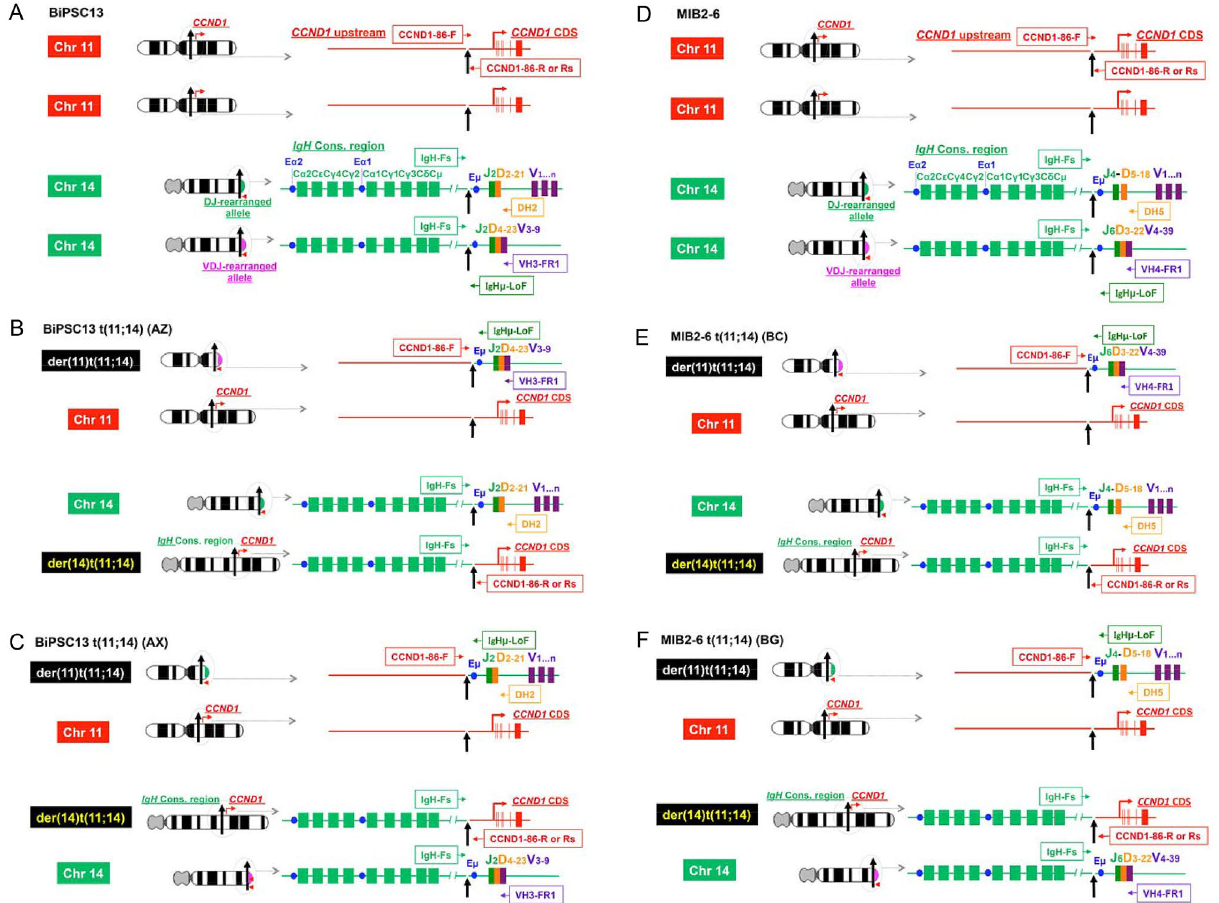
Figure 1. Features of the reciprocal chromosomal translocation (cTr) between CCND1 on chr 11 and IgH on chr 14. (A, D) Two pairs of IgH on chr 14 and CCND1 on chr 11 of BiPSC13 and MIB2-6 are shown. The cleavage site of CRISPR/Cas9 is indicated by ( ↑ ). The bent arrows and arrowheads indicate the direction of transcription of CCND1 and IgH , respectively. CCND1-86F, CCND1-86R, IgH-Fs, DH2, DH5, VH3-FR1, VH4-FR1, IgHu-LoF represent PCR primers for the confirmation of cTr t(11;14). (B) Reciprocal cTr between the functional allele (V 3-9 D 4-23 J 2 ) of IgH and CCND1 in BiPSC13 (AZ). (E) Reciprocal cTr between the functional allele (V 4-39 D 3-22 J 6 ) of IgH and CCND1 in MIB2-6 (BC). (C) Reciprocal cTr between the non- functional allele (D 2-21 J 2 ) of IgH and CCND1 in BiPSC13 (AX). (F) Reciprocal cTr between the functional allele (D 5-18 J 4 ) of IgH and CCND1 in MIB2-6 (BG). (G)(H) Confirmation of reciprocal cTr between IgH and CCND1 with PCR. PCR in BiPSC13 and two types of BiPSC13 with t(11;14) (AZ and AX) (G) and PCR in MIB2-6 and two types of MIB2-6 with t(11;14) (BC and BG) (H). Refer to (A) and (D) above for the location of each primer. The numbers indicate the length of the PCR product estimated from the database. (I) Confirmation of der(14) t(11;14) and der(11)t(t(11;14) in AZ, AX, BC, and BG with PCR. Refer to (A) and (D) above for the location of each primer. (J,K) Chromosomal t(11;14)-specific FISH of AZ and AX (J), and BC and BG (K). One chr 11 and chr 14 was reciprocally translocated. CCND1 and IgH probes are labeled with red and green boxes, respectively. The arrowheads indicate the IgH-CCND1 fusion signal. (L,M) Reciprocal cTr t(11;14) junction sequence of AZ and AX (L), and BC and BG (M). The dotted line indicates the cleavage site (usually three bases from the PAM region). Details are described in the